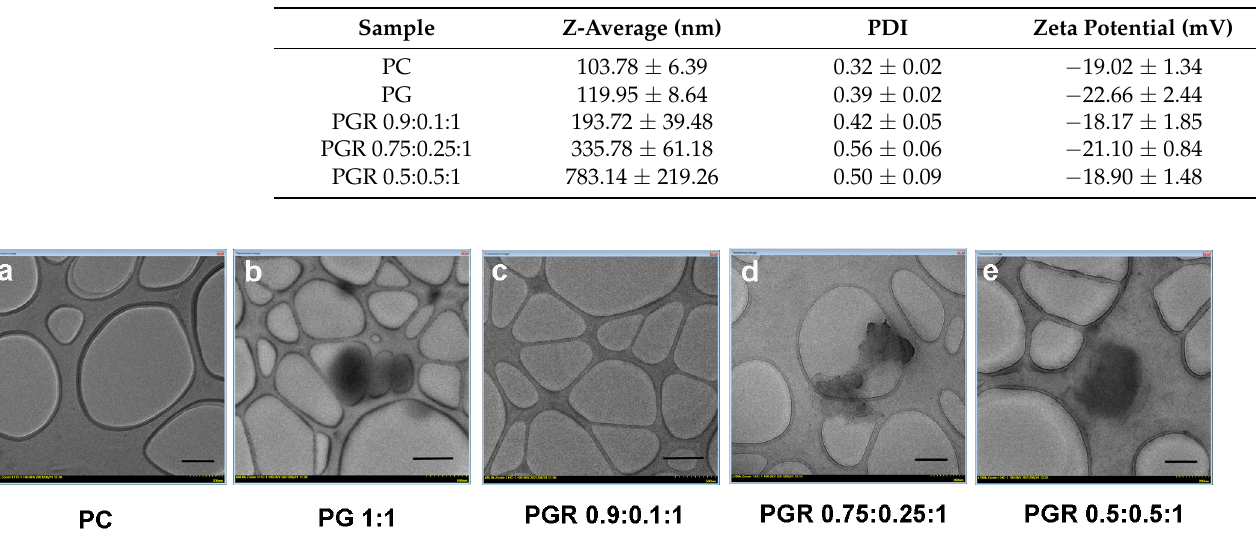
Table 4. The values of the Z-average, polydispersity index (PDI) and Zeta potential of phosphatidyl- choline (PC), PHYTOGIN (PG) and PHYTOGINROSA (PGR) in the three formulations.